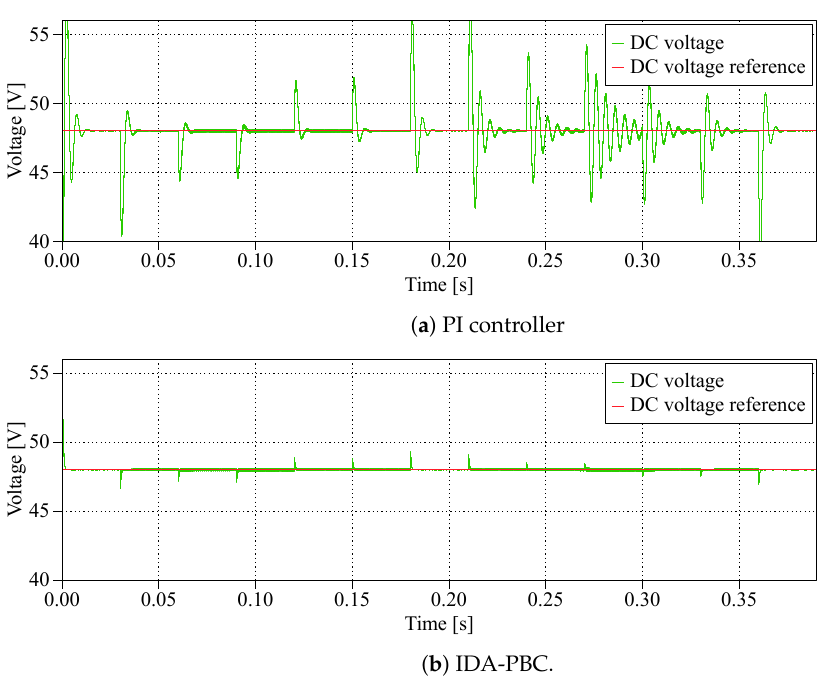
Figure 4. The dynamic response of output voltage of the interleaved boost converter under different DC current